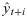
Deep Heart-failure Trajectory (DHTM) Model.During the training, DHTM learns to predict the next time point using observed acute CMs ci and HF yi for each patient. After training, DHTM can make a trajectory prediction using the acute CMs at the last observed time point ct and its own predicted HFH y^t+i as input for predicting HFH y^t+i+1 at time point t + i + 1, where i is the number of predicted time points so far. Thisauto-regressive process continues in an arbitrary number of future time points.